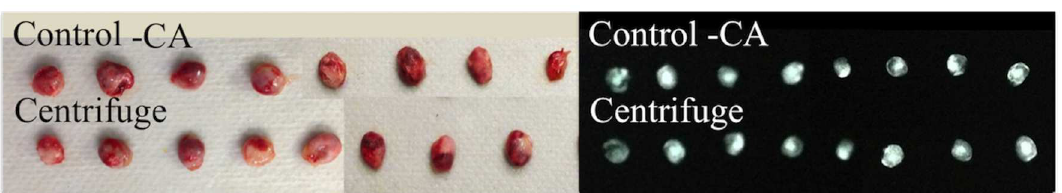
Fig 5. Macroscopic (left panel) and radiographic (right panel) aspects of ectopic bones between two groups (Control-CA: Control group of constant acceleration groups, Centrifuge: Centrifuge group).